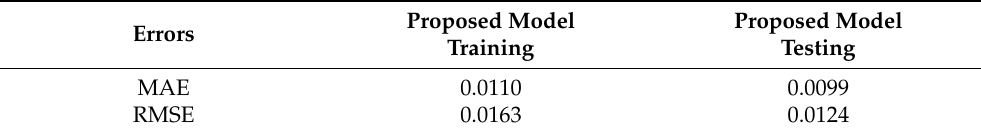
Table 6. A comparison between the test and train error results of the proposed model.